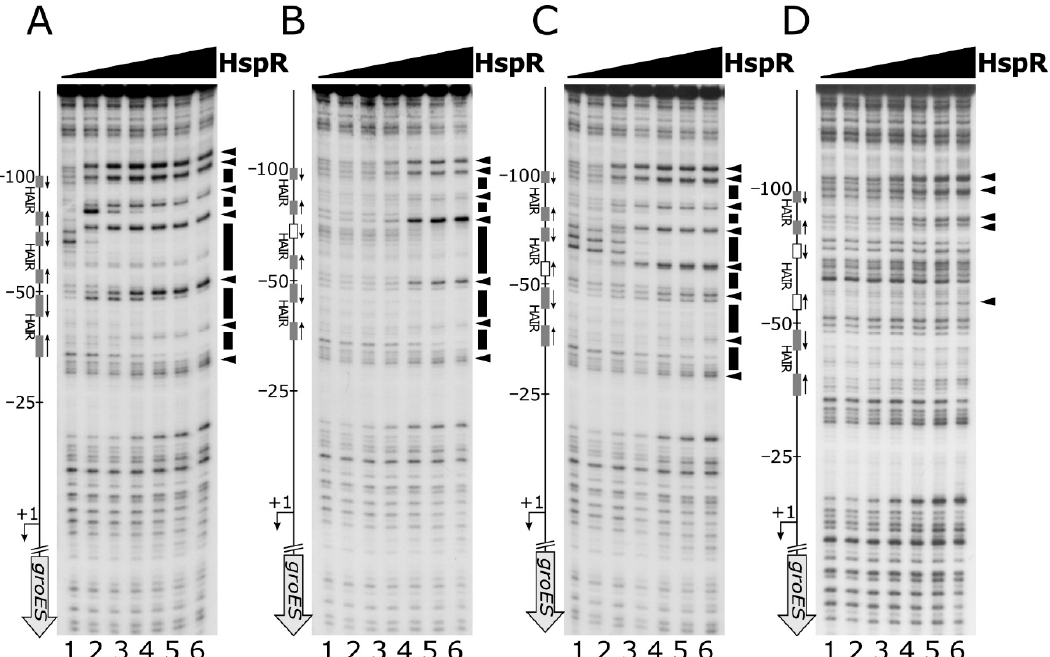
Figure 3. DNase I footprinting assays of HspR on wild type P gro (panel A ) and on a set of mutant probes, comprising the mutant of the more conserved HAIR hemisite (panel B ), of the less conserved HAIR hemisite (panel C ) and the mutant of both HAIR hemisites (panel D ). Radiolabelled DNA probes were incubated with increasing concentrations of recombinant HspR protein (0, 22, 45, 90, 180, 360 and 720 nM HspR; lanes 1 to 7, respectively) and subjected to partial DNase I digestion. On the right of each panel, black boxes depict the regions of protection and black arrowheads indicate bands of hypersensitivity to DNase I digestion. On the left side of each panel, a schematic representation of the promoter region, where the bent arrow indicates the transcriptional start site, while the vertical open arrow depicts the open reading frame and grey or white (if mutated) boxes alongside with converging arrows indicate the positions of the HAIR ‐ like sequences; numbers refer to the positions with respect to the transcriptional start site.